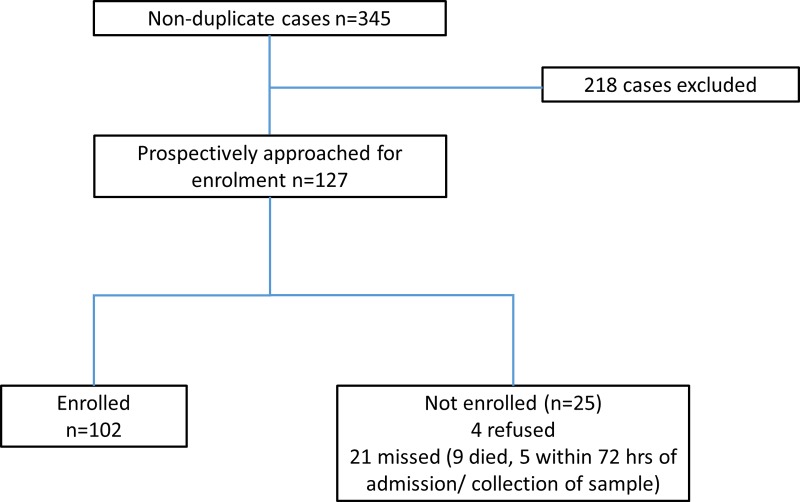
Screening and enrolment of participants.